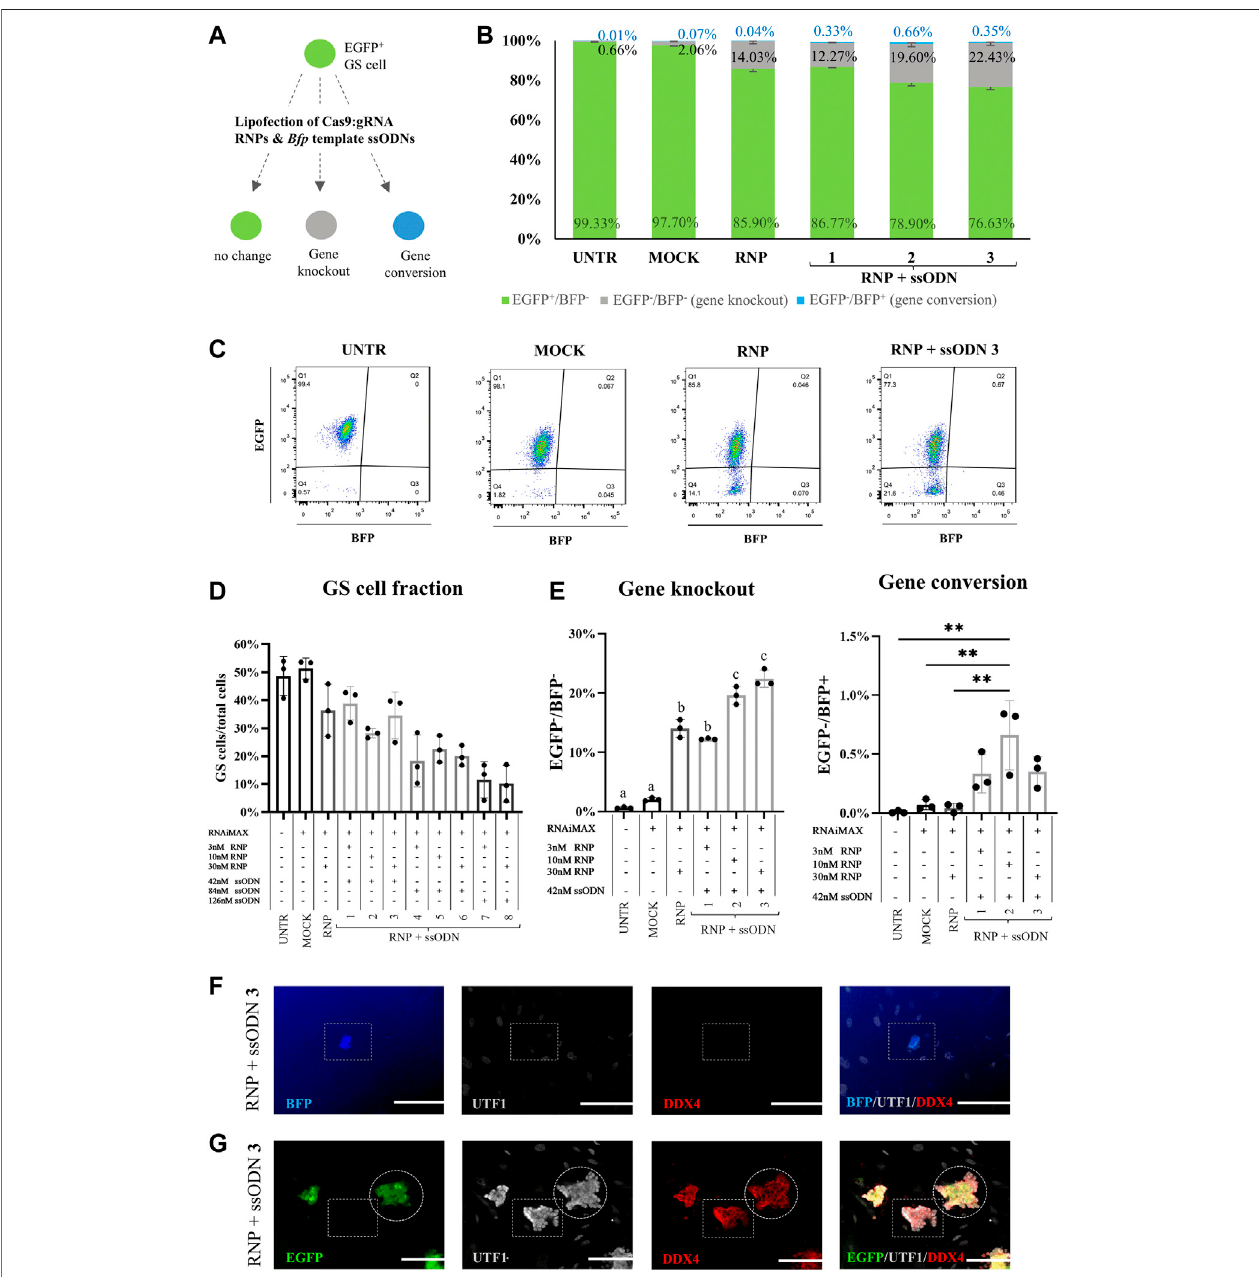
FIGURE 3 | Gene editing in GS cells. (A) Cas9:gRNA RNP and Bfp template ssODN were lipofected in GS cells to test gene knockout (EGFP − /BFP − ) and gene conversion(EGFP − /BFP + ). (B) Geneknockout(EGFP − /BFP − ,greybars),geneconversion(EGFP − /BFP + ,bluebars)andunaffectedcells(EGFP + /BFP − ,greenbars)inthe GS cell gate, 10 days after transfection. (C) Representative EGFP/BFP dot plots 10 days after transfection. Flow cytometry detected gene knockout (EGFP − /BFP − ) in conditions lipofected with RNP and RNP + ssODN but not in the UNTR and MOCK control. Co-lipofection of RNP and ssODN caused only gene conversion in a smallfractionofthegatedGScellphenotype. (D) CalculatingtheGScellfraction(GScells/allcellspresentinculture)revealedthathighconcentrationsofssODNreduced the GS cell fraction, while RNAiMAX treatment (MOCK) had no effect and RNP administration (RNP) only a slightly reducing effect on the GS cell fraction. Due to the low GS cell fraction ( > 2-fold decrease), conditions 4 – 8 were excluded from further analysis. (E) Gene knockout (EGFP − /BFP − ) was detected in all conditions which were transfected with RNP (RNP and RNP + ssODN 1 – 3). Condition 3 was identi fi ed as the best condition, with a signi fi cant increase in Egfp knockout compared to UNTR, MOCK, RNP and RNP + ssODN 1. Statistical signi fi cance was assessed performing a one-way ANOVA followed by a multiple comparison Turkey´s test. a,b,c p ≥ 0.05. RNPvs.2: p < 0.001.Allothercomparisons: p < 0.0001.Geneconversionwasdetectedafterco-lipofectingRNPandssODN,butonlyin < 0.70%ofthepopulationinthe GS cell gate. Statistical signi fi cance was tested using a one-way ANOVA, followed by a multiple comparison Turkey´s test. ** p < 0.01. (F) BFP-expressing cells were detected in the culture, but ultimately not identi fi ed as GS cells, as they did not express their speci fi c marker (UTF − /DDX4 − ). (G) EGFP + and EGFP − GS cell colonies maintained the undifferentiated germ cell status (UTF1 + /DDX4 + ) 10 days after transfection. n = 3 technical replicates. Scale bars represent 100 µm.